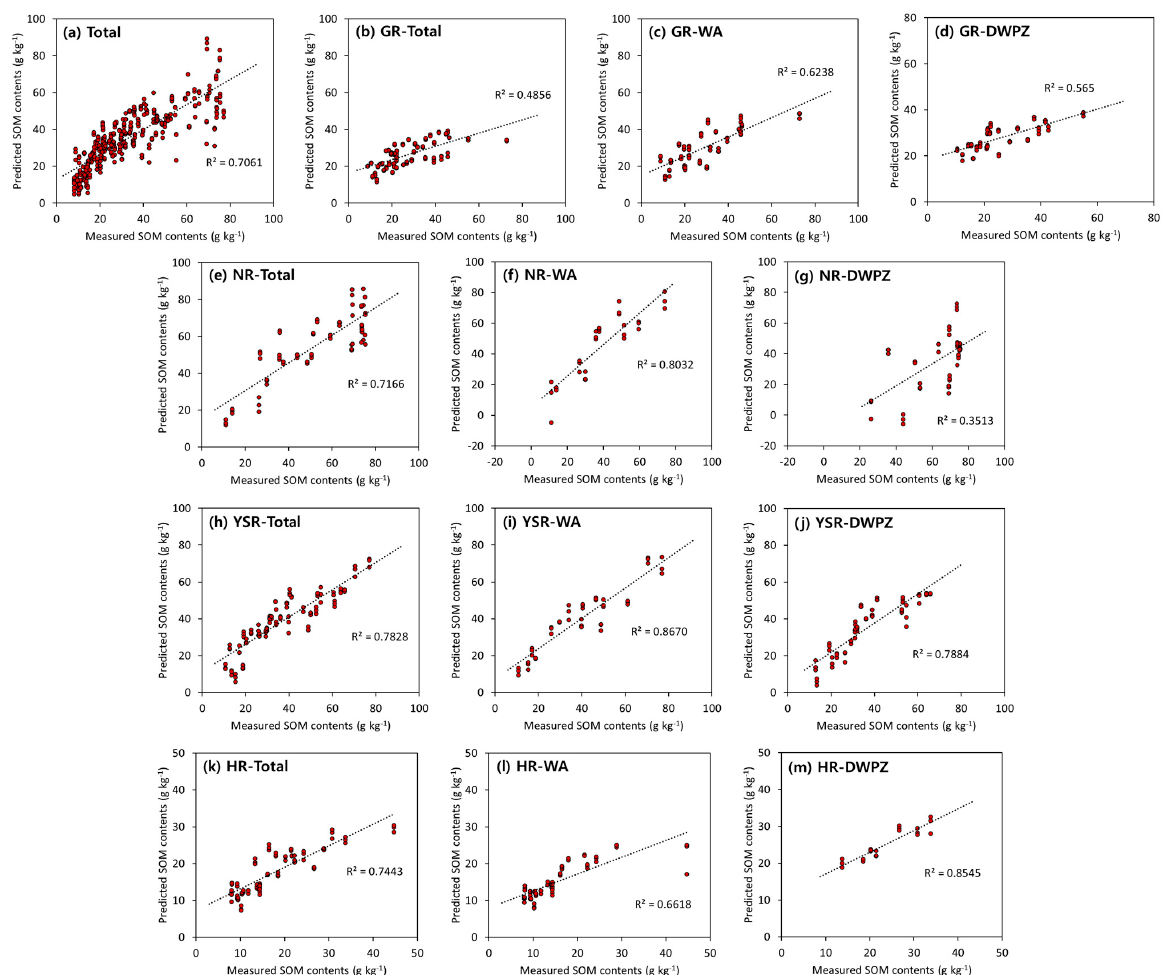
Figure 6. Scatter plot of predicted vs. measured SOM in the prediction dataset for the optimal model in each of the four major rivers ( a – m ) built based on calibration